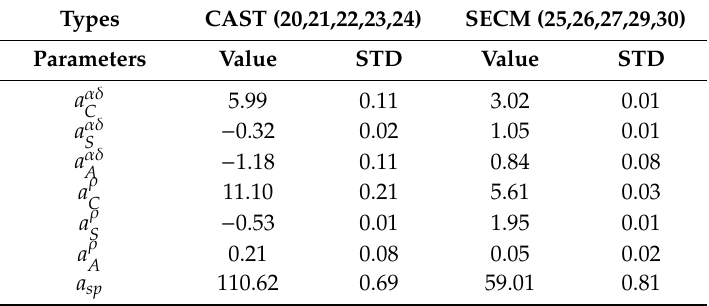
Table 5. Estimations of the cuboid and constant parameters for the BeiDou-3 satellites. The unit is nm / s 2